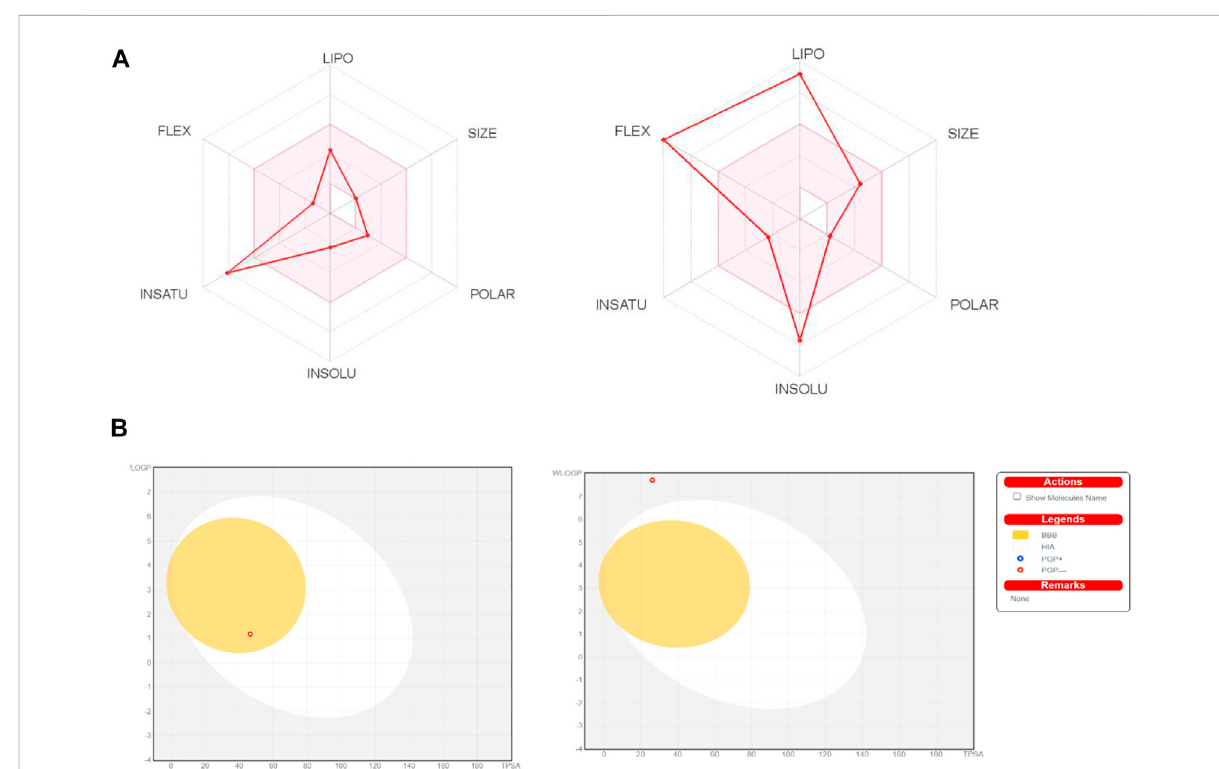
FIGURE 2 (A) Bioavailability radar chart for methyl dihydroxybenzoate and heptadecyl benzoate respectively. (B) Predicted BOILED-Egg plot from swiss ADME online web tool for methyl dihydroxybenzoate and heptadecyl benzoate